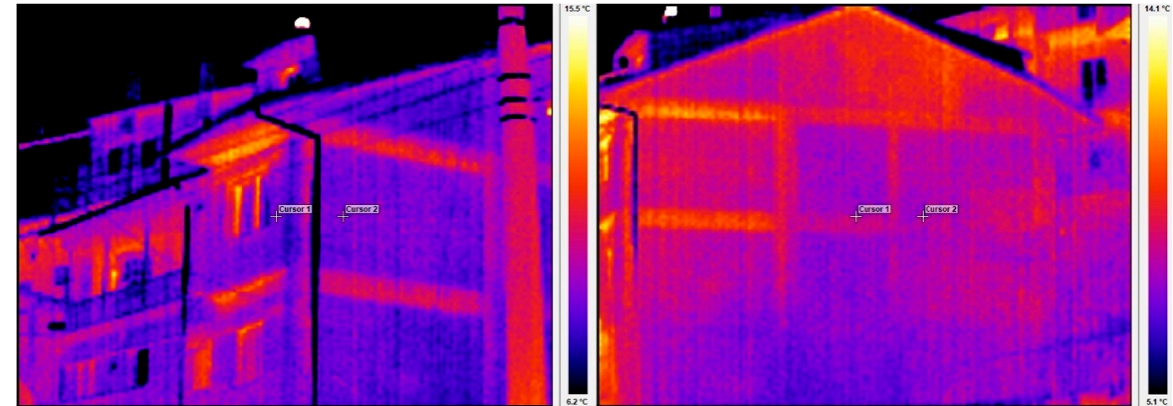
Figure 1. Thermal imaging during the Mountainous Living Lab [49].